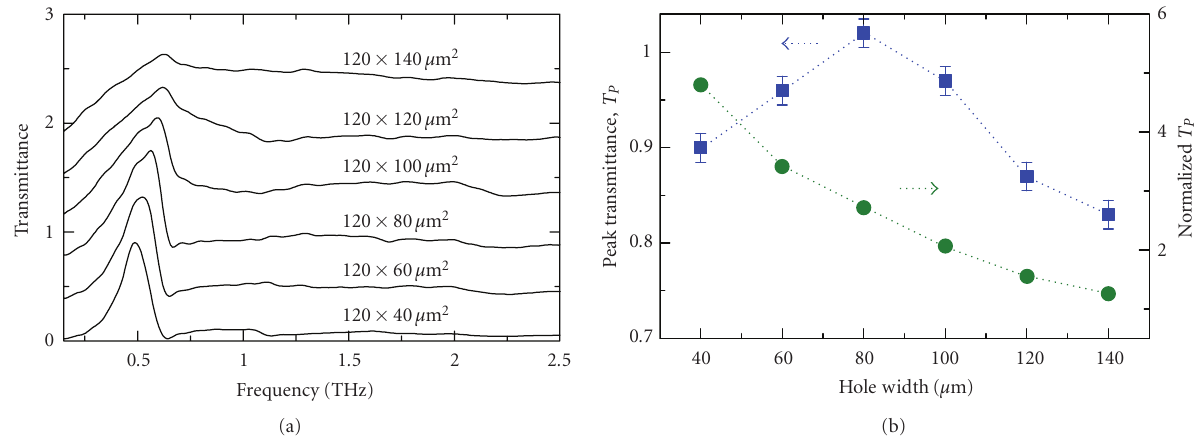
Figure 8: (a) Measured absolute transmittance of the hole arrays with fixed hole length of 120 μ m and various hole widths from 40 to 140 μ m. For clarity, the curves are vertically displaced by 0.36. (b) Absolute (squares) and normalized (circles) peak transmittance as a function of hole width. The dotted lines are a guide to the eye.